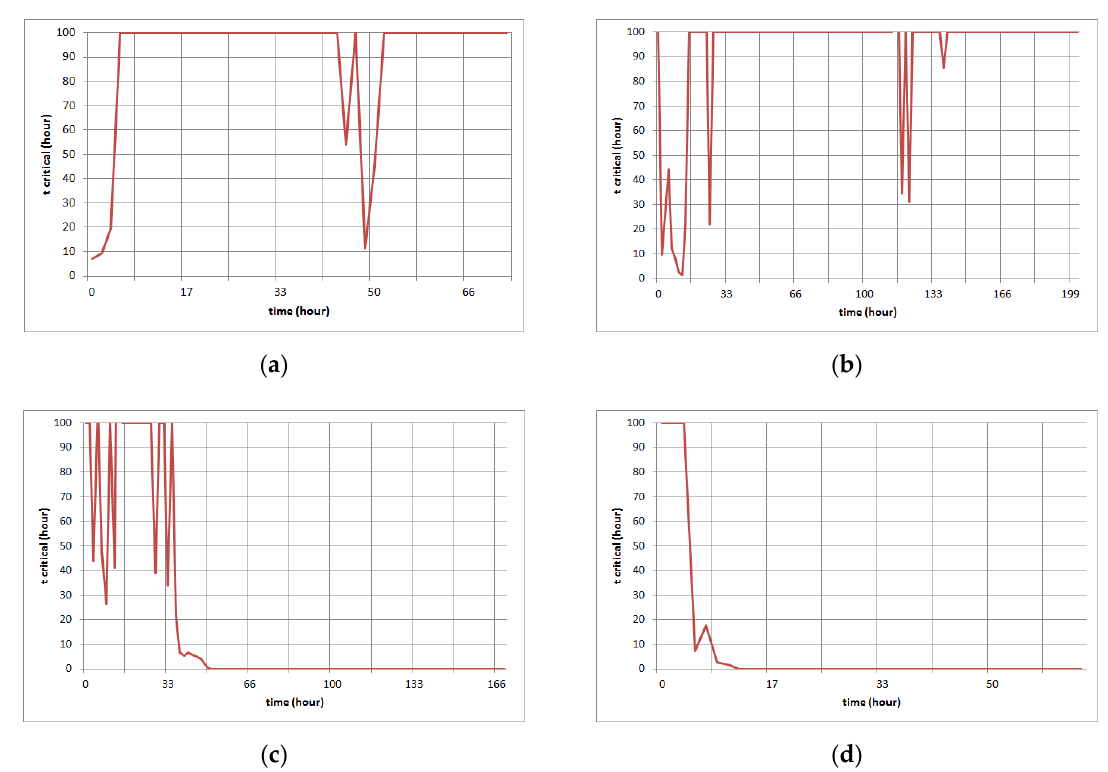
Figure 8. The critical time for the possibility of CO poisoning during experiment for the ( a ) experiment #1, ( b ) experiment #2, ( c ) experiment #3, and ( d ) experiment #4.